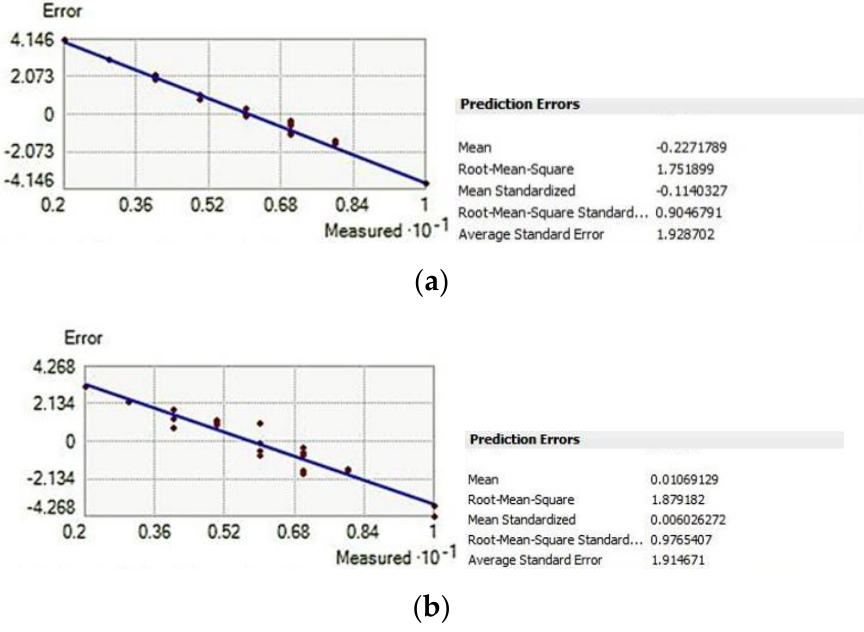
Figure 11. Cross-validation of subset between the ( a ) Co-Kriging and ( b ) IDW result.